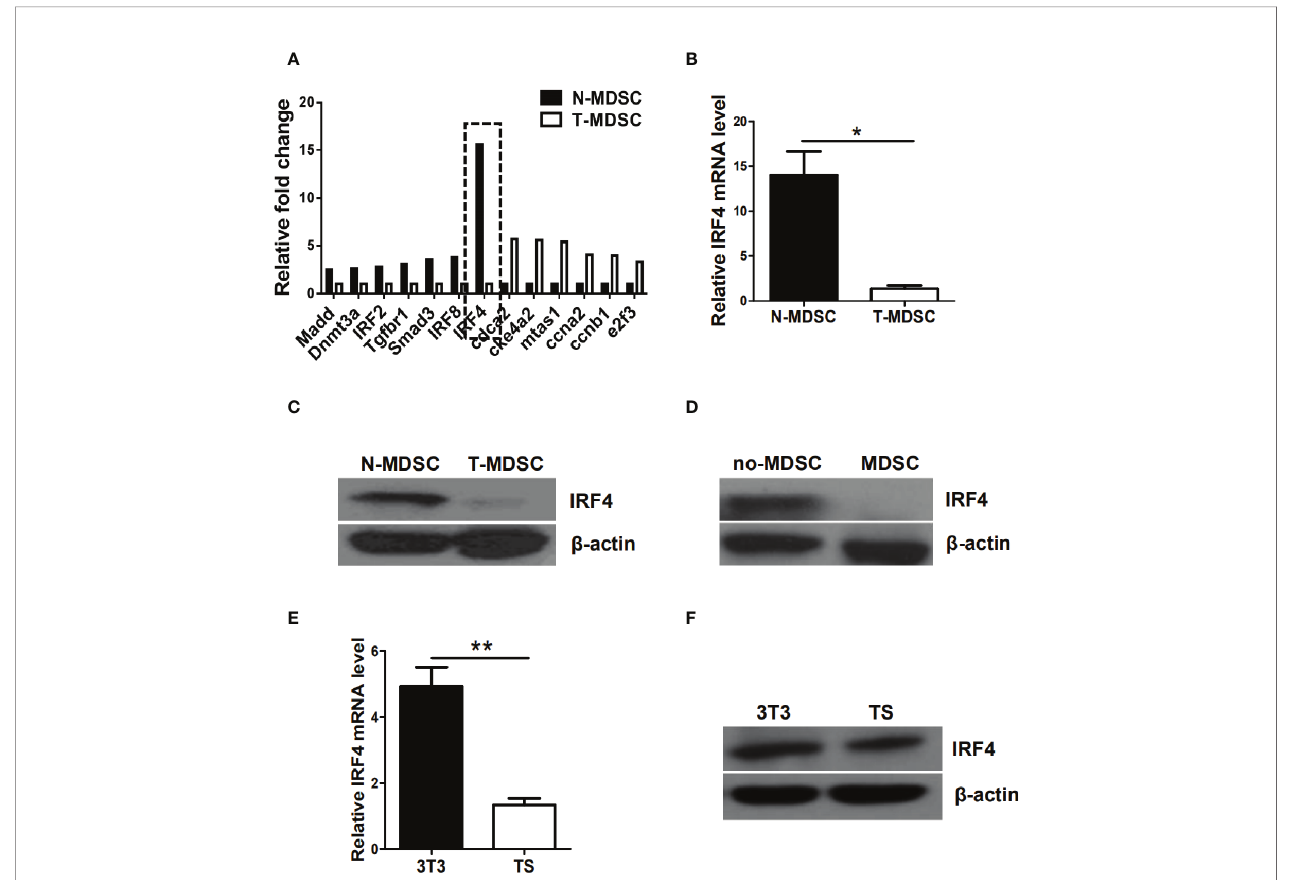
FIGURE 1 | Interferon regulatory factor 4 (IRF4) expression decreases in tumor-derived MDSCs. (A) Microarray analysis showing differentially expressed genes in splenic myeloid-derived suppressor cells (MDSCs) from tumor-bearing mice was injected with B16-F10 cells via the subcutaneously (T-MDSC) and the corresponding control cells from naive mice (N-MDSC). (B) Interferon regulatory factor 4 (IRF4) was evaluated by qRT-PCR with additional samples. (C) IRF4 expression in splenic MDSCs from tumor-bearing mice and control cells from naive mice was determined by a western blot (WB). (D) IRF4 expression in splenic CD11b + Gr1 + cells and CD11b + Gr1 - cells from tumor-bearing mice was determined by WB. (E, F) Bone marrow (BM) cells from naive mice were cultured with GM- CSF and IL-6 in the presence of 30% (vol/vol) 3T3 or B16-F10 tumor supernatants (TS); IRF4 expression was evaluated by qRT-PCR (e) and WB (f). (B, E) Data are shown as the mean ± SEM of six samples from three independent experiments. * P < 0.05, ** P < 0.01 compared with the corresponding controls in unpaired t